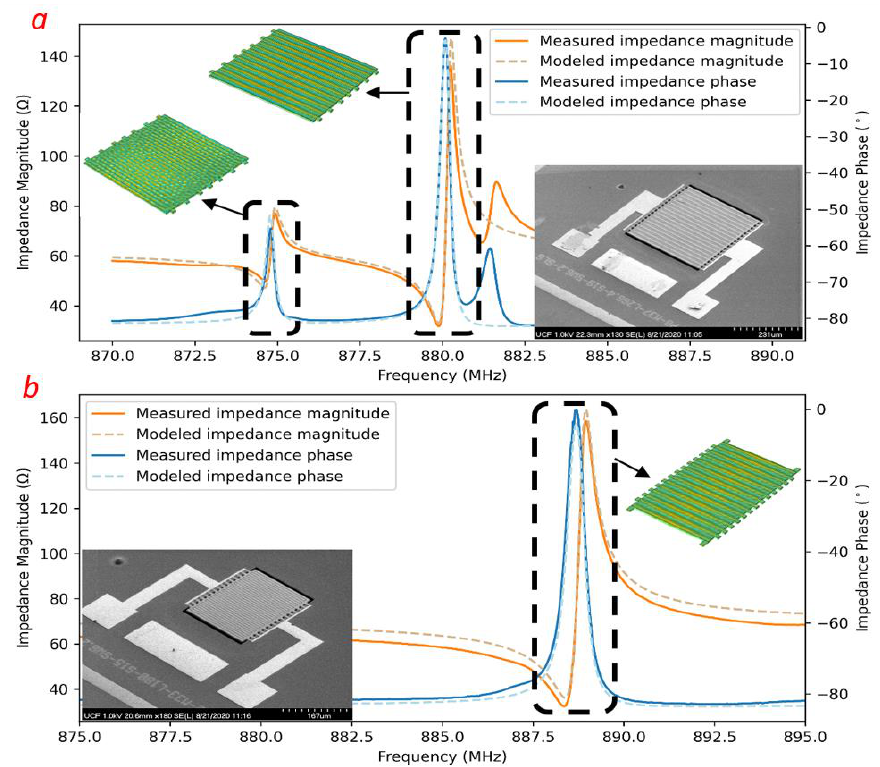
Figure 3. The measured and modeled impedance magnitude and phase of MEMS#1 ( a ) and MEMS#2 ( b ) resonators used in the sensor with the mode shapes (as simulated using COMSOL) corresponding to ( a ) 874.7 MHz and 879.9 MHz and ( b ) 888 MHz modes placed as insets.